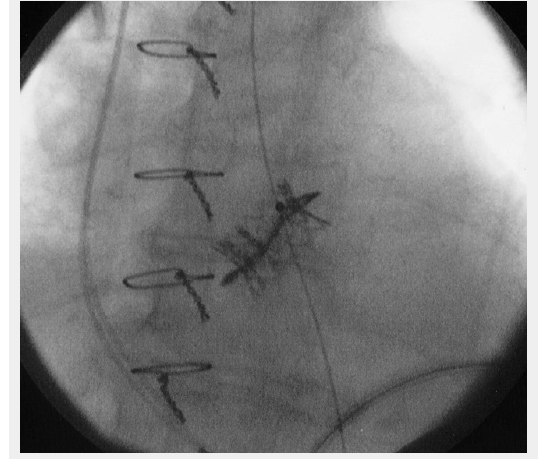
Image taken from the fluoroscopy system showing a transapical valve-in-valve procedure (a 23 mm Sapien TM THV into a degenerated 23 mm Mitroflow